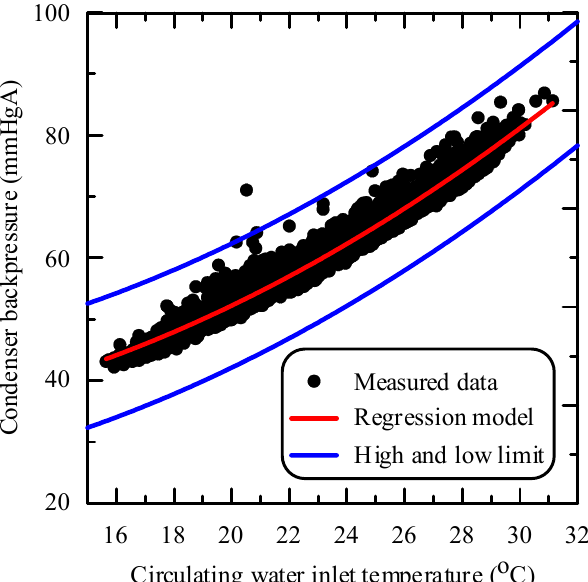
The solid curve (red color) shown in Figure 6 provides the curve fitting regression model representing condenser backpressure as a function of circulating water inlet temperature. Figure 6. Regression model of condenser backpressure versus circulating water inlet